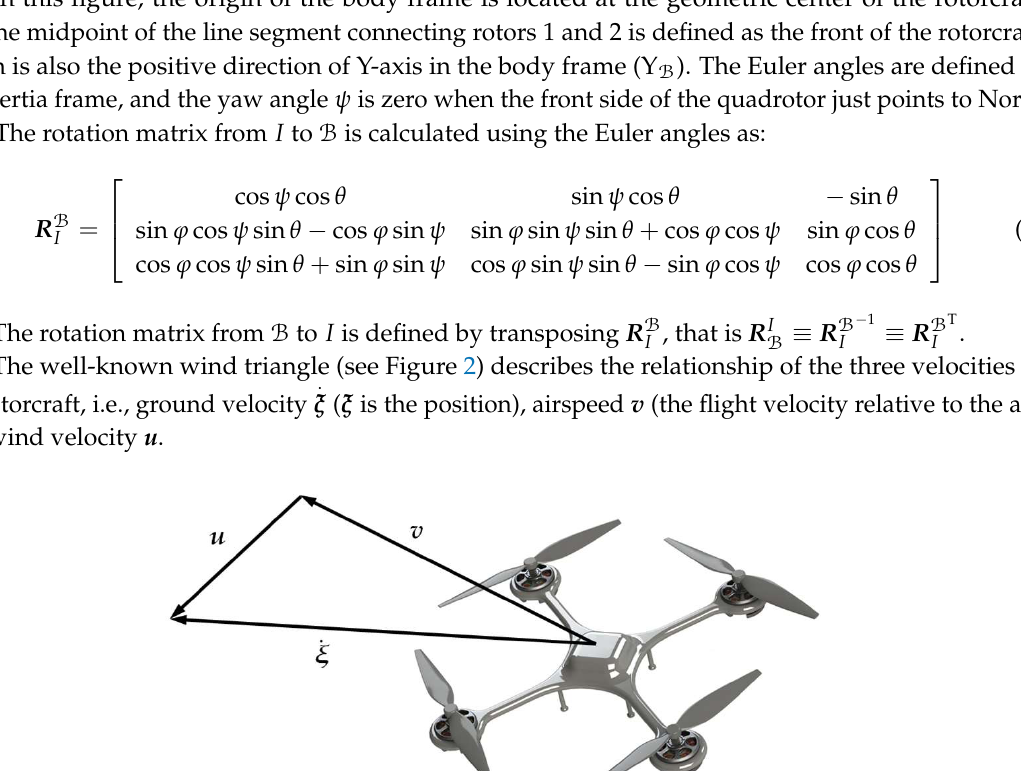
Figure 1. The inertia frame and the body frame of the rotorcraft. The three axes of the body frame B and inertia frame I are illustrated by the black vectors. The blue arrows and letters represent Euler angles: roll ( φ ), pitch ( θ ), and yaw ( ψ ). The red arrows show the rotational directions of the rotors.